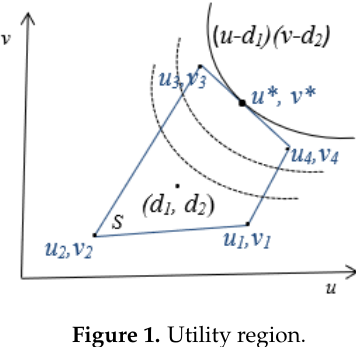
Figure 1. Utility region.